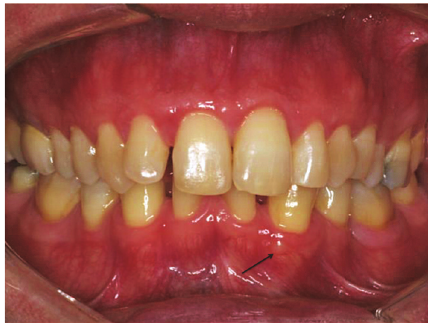
Figure 1: Clinical aspect of the lesion (arrow), showing the very small size of the lesion, denoting the difficulty in spotting it without thorough examination.